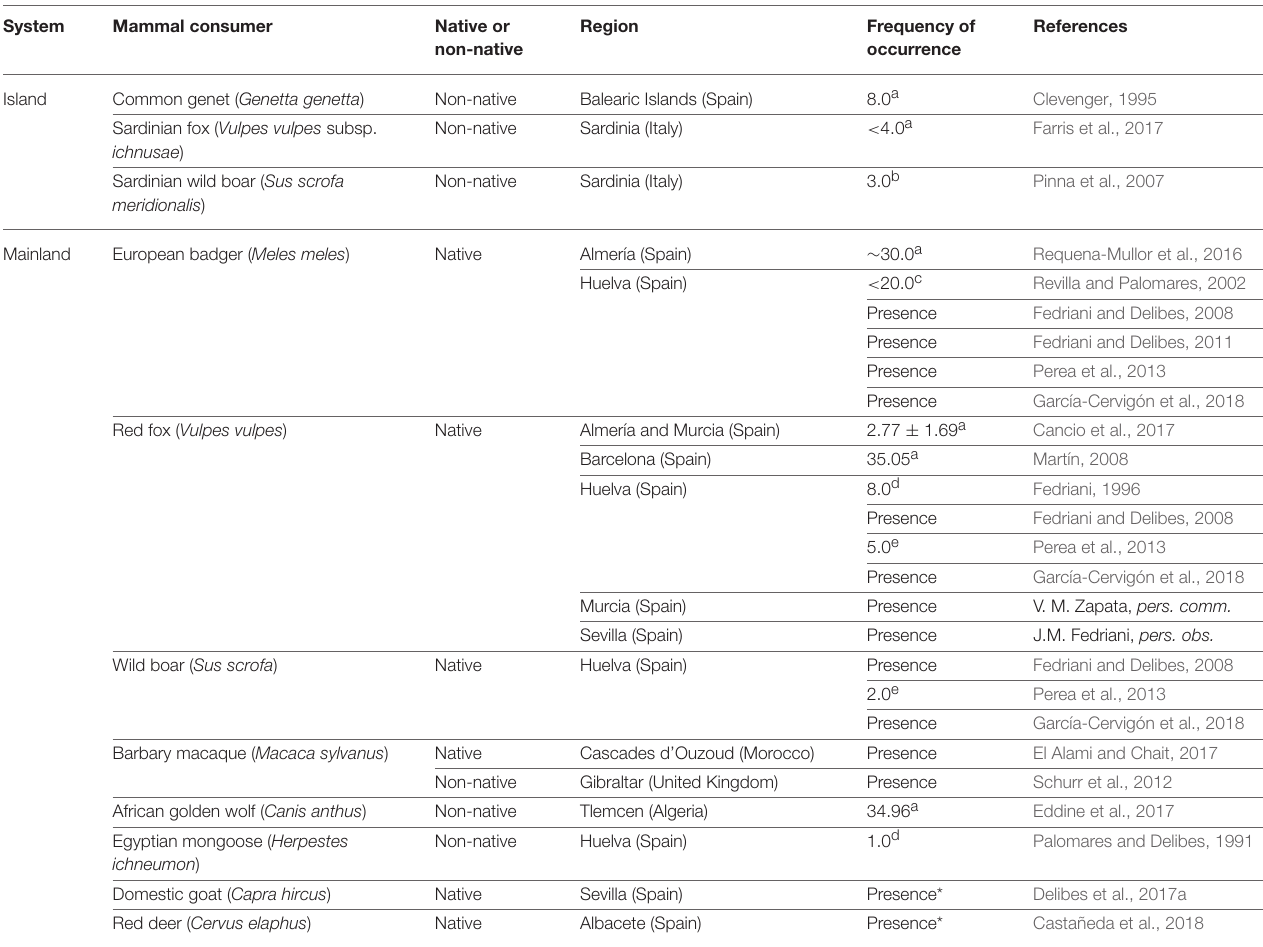
TABLE 1 | Mammal species that consume C. humilis fruits described in the Mediterranean basin so far, indicating the system (island or mainland), the region, whether they are native or not, the frequency of occurrence of dwarf palm fruits in their diet, and the reference of the